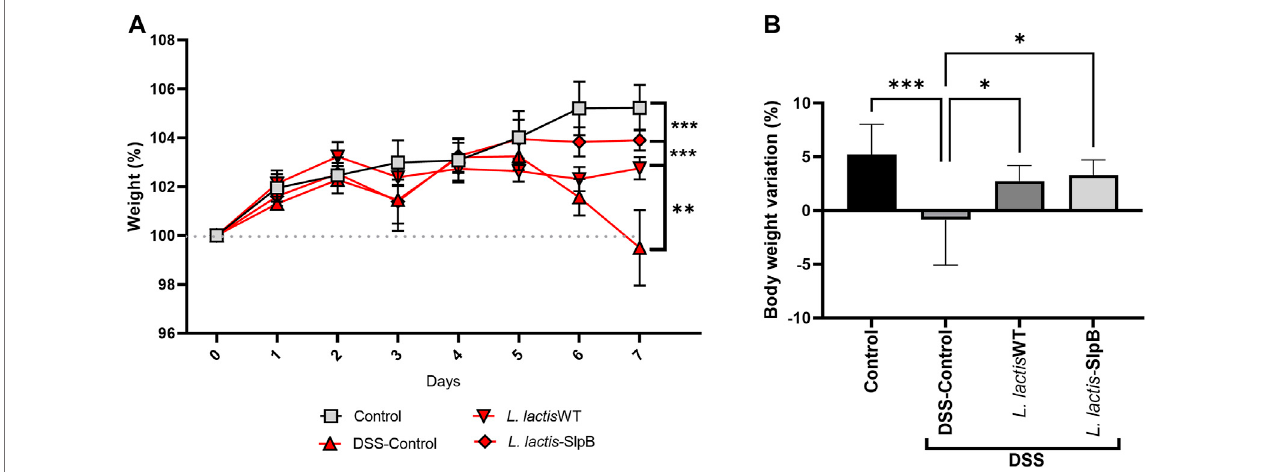
FIGURE 1 | Lactococcus lactis -Surface-layer protein (Slp)B is able to control weight loss in Dextran Sulfate Sodium (DSS)-induced colitis. Time-course of body weightduringthesevenexperimentaldays (A) andweightloss (B) areshown.Thetwo-wayANOVA (A) ,one-wayANOVA (B) ,andTukey ’ s post - hoc testswereusedfor the multiple comparisons (The data represent the mean ± SD of 12 mice per group). Asterisks represent statistically signi fi cant differences as follows: p p < 0.05, pp p < 0.01, ppp p < 0.001, pppp p <